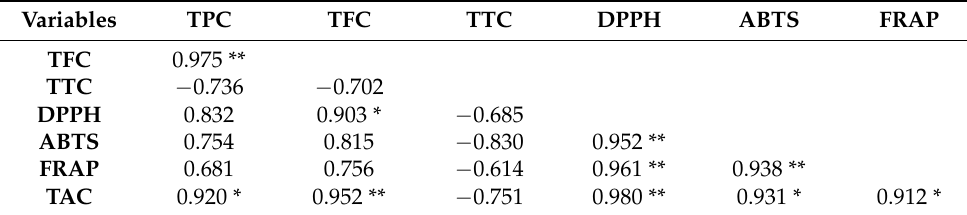
Table 2. Correlation coefficients ( r 2 ) between phenolic contents and antioxidant assays. Variables